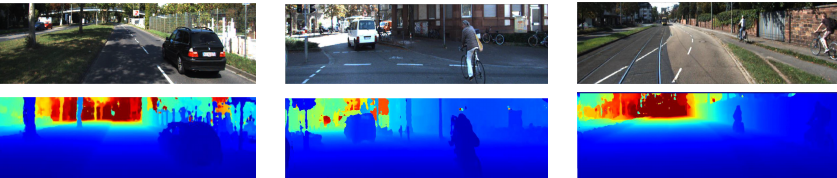
Figure 13. The qualitative results from [32] show the left RGB images from 3 scenes in the KITTI raw dataset in the top row and the corresponding depth map predictions in the bottom row are shown using colour to represent the depth